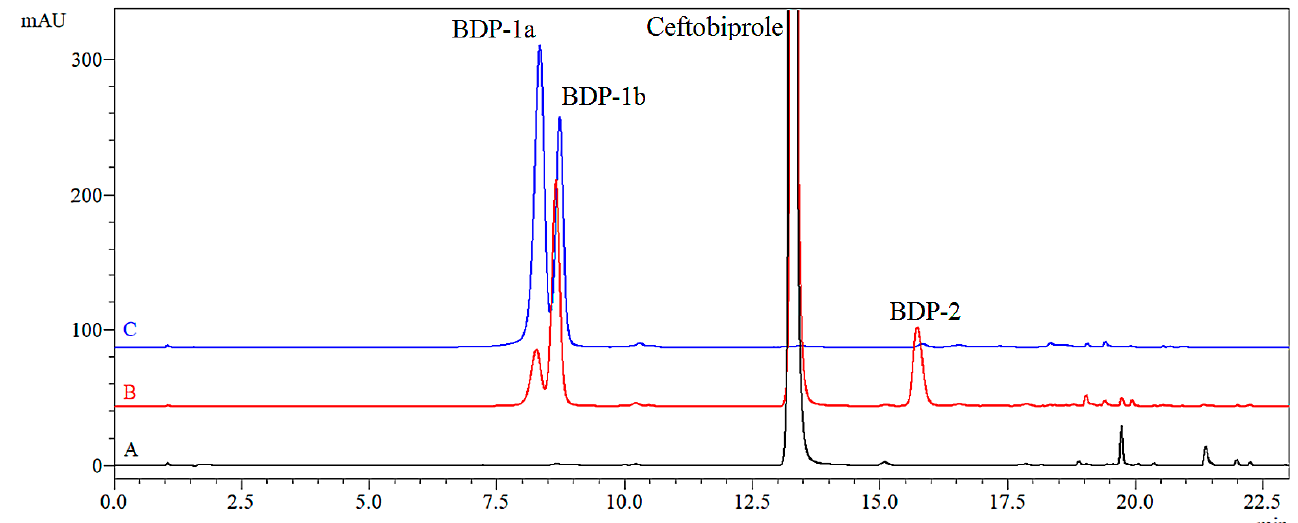
Figure 5. Overlaid chromatograms obtained from the separation of a 1 mg/mL ceftobiprole solution by alkaline hydrolysis in 0.01 M NaOH: ( A ) at time 0; ( B ) after 45 min; ( C ) after 720 min.